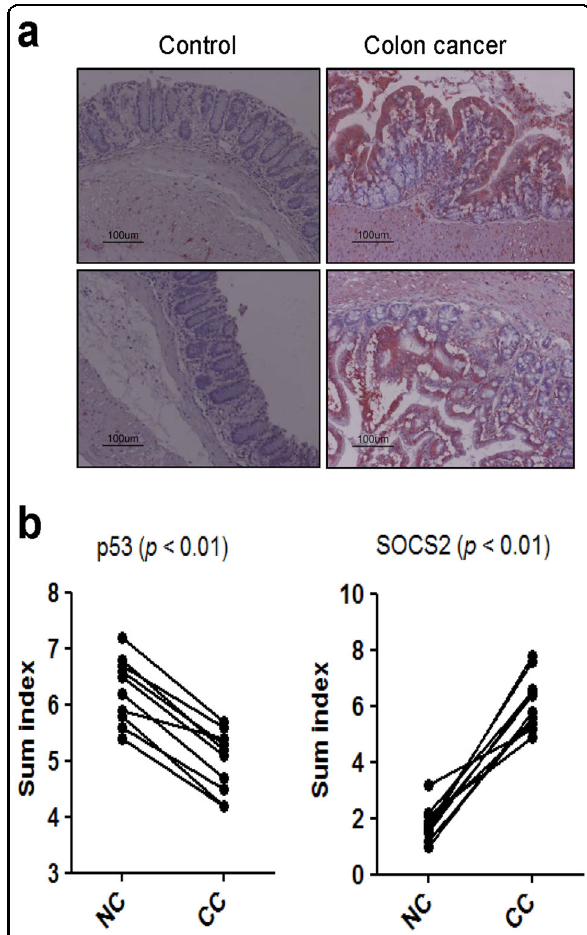
Fig. 4 Immunohistochemistry of colon carcinoma induced by azoxymethane and dextran sulfate sodium in a mouse model. a Strong SOCS2 expression was detected in most colon carcinomas compared with control tissues ( n = 10, P < 0.01). b Sum index of p53 or SOCS2 immunohistochemical staining in noncancer (NC) tissues and colon cancer (CC) tissues,